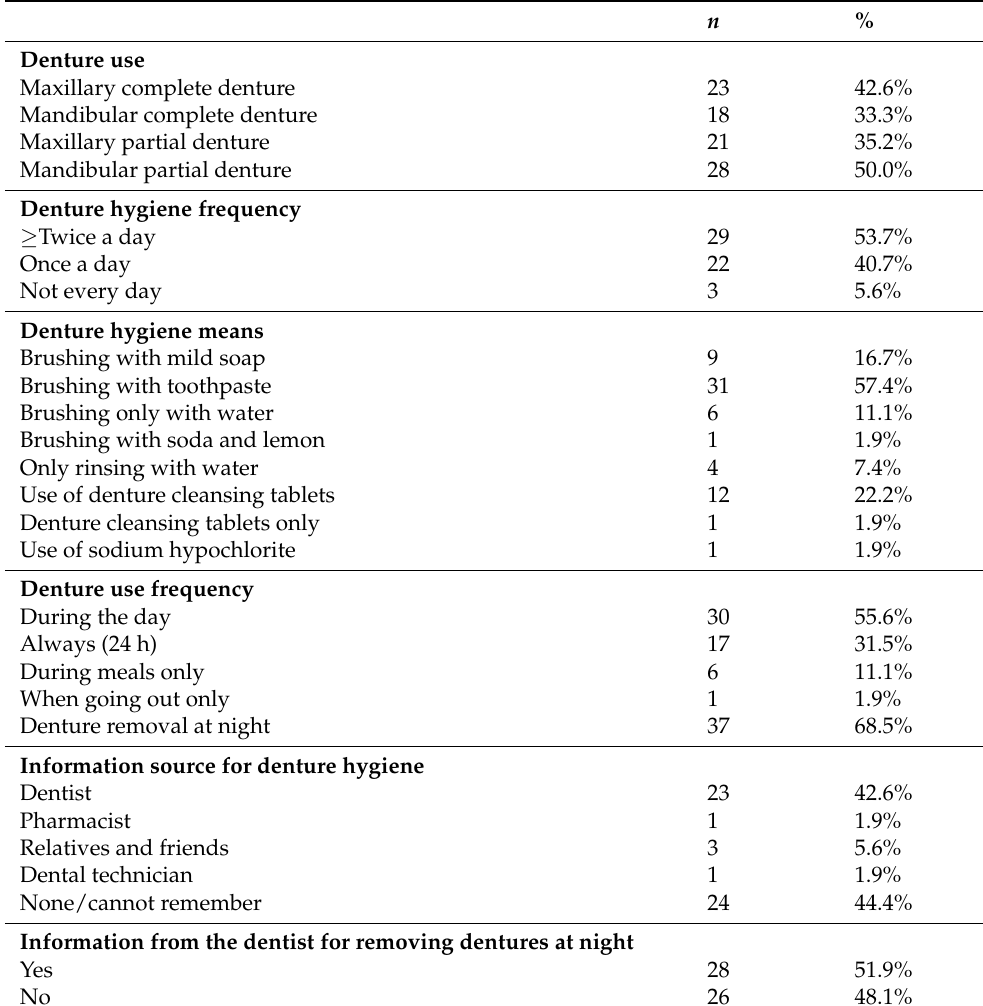
Table 3. Dentures’ use, dentures’ hygiene habits and sources of information about daily dentures’ care among denture wearers ( n =